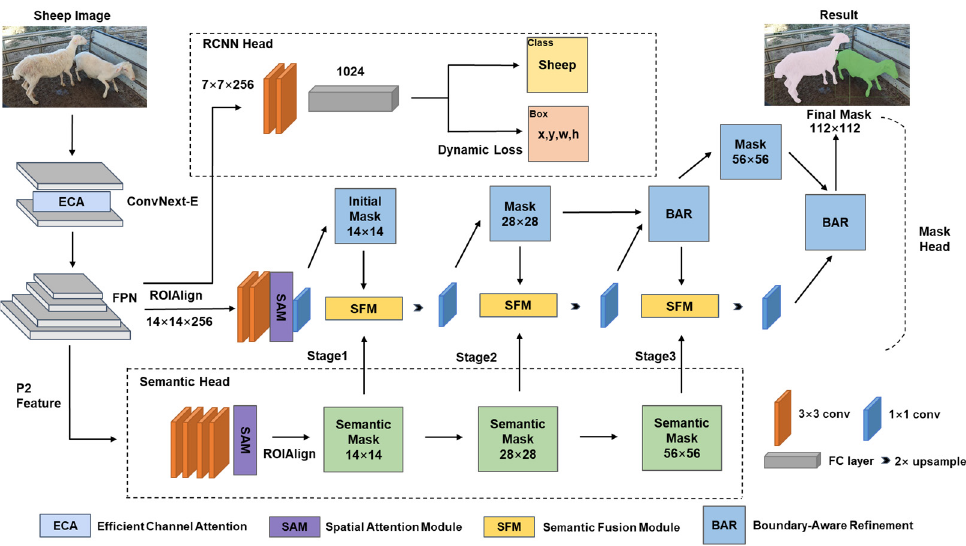
Figure 3. The overview of SheepInst.